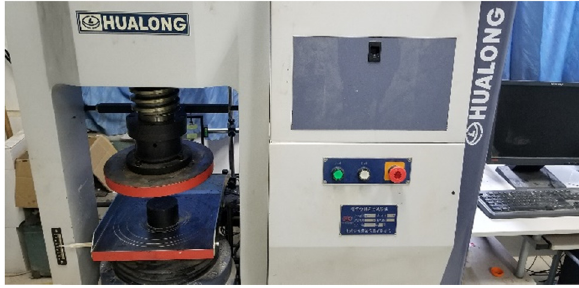
Figure 8: Compressive strength test apparatus.